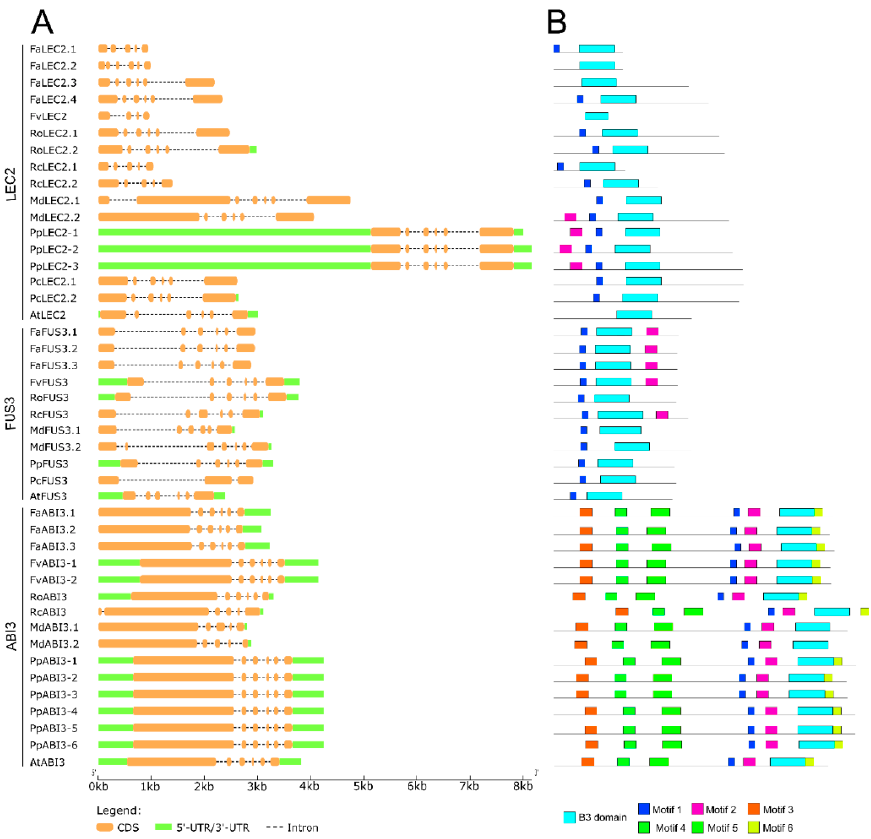
Figure 2. LEC2, FUS3, and ABI3 gene and protein structures in Rosaceae species and Arabidopsis thaliana . ( A ) Exon–intron structure of LEC2 , FUS3 , and ABI3 genes. ( B ) B3 domain and motifs in LEC2, FUS3, and ABI3 proteins. LEC2 : LEAFY COTYLEDON2 ; FUS3 : FUSCA3 ; ABI3 :